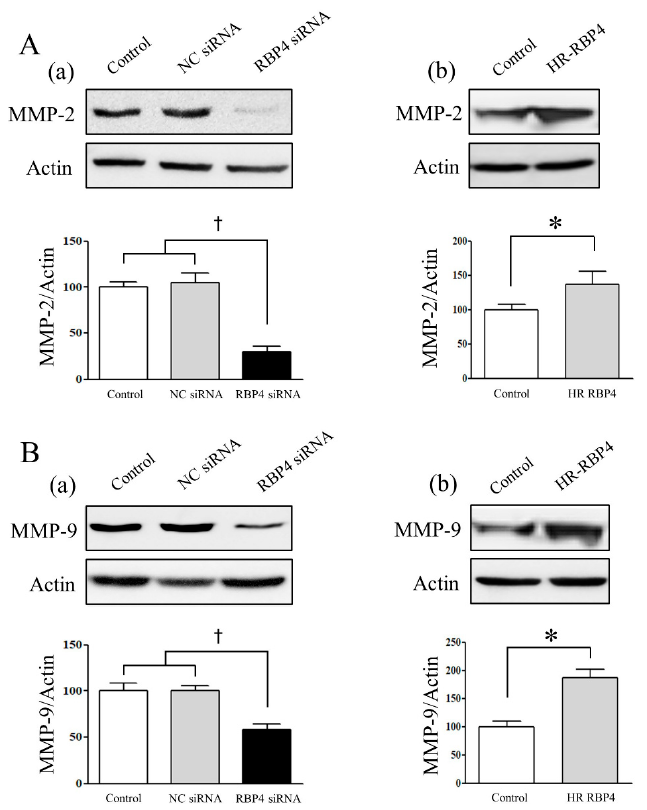
Figure 4. Expression of MMP-2 ( A ) and MMP-9 ( B ) in the endometrial stromal cells following treatment with the vehicle, transfection with the negative control siRNA or RBP4 siRNA ( a ), or treatment with HR-RBP4 ( b ). The error bars represent the mean ± SEM. Data are expressed as a percentage, in which the cells treated with the control are normalized to 100%, † p < 0.05 compared with vehicle group as well as negative control siRNA transfection group. * p < 0.05 compared with the control group. NC: negative control.